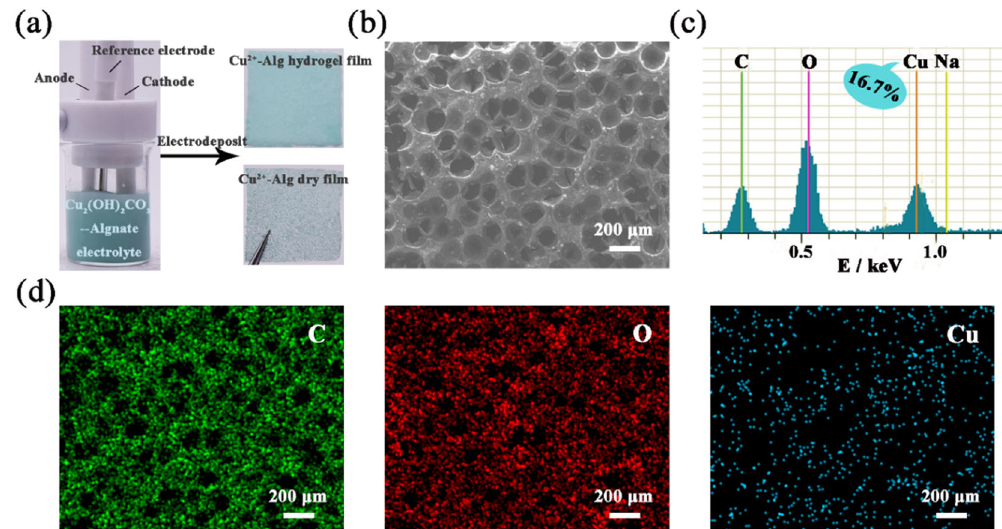
Fig. 1 a The photographs of gel and dry Cu 2 + -Alg fi lms prepared by electrodeposition. b Surface SEM image of (Cu 2 + -Alg) 0.54C . c EDS spectra of (Cu 2 + -Alg) 0.54C . d EDS mapping of C, O, and Cu elements within the dressing, respectively